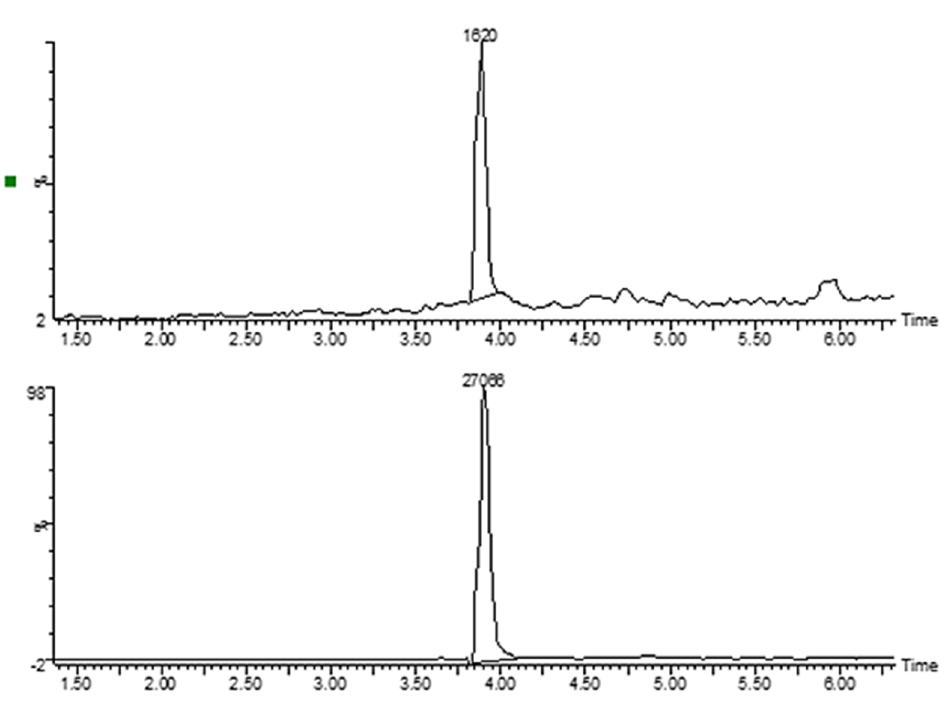
Figure 4. Mass chromatograms for m/z 455.18 ions in extracts from colon cancer SW-480 cell line—upper chromatogram MTX, lower GLU–MTX.